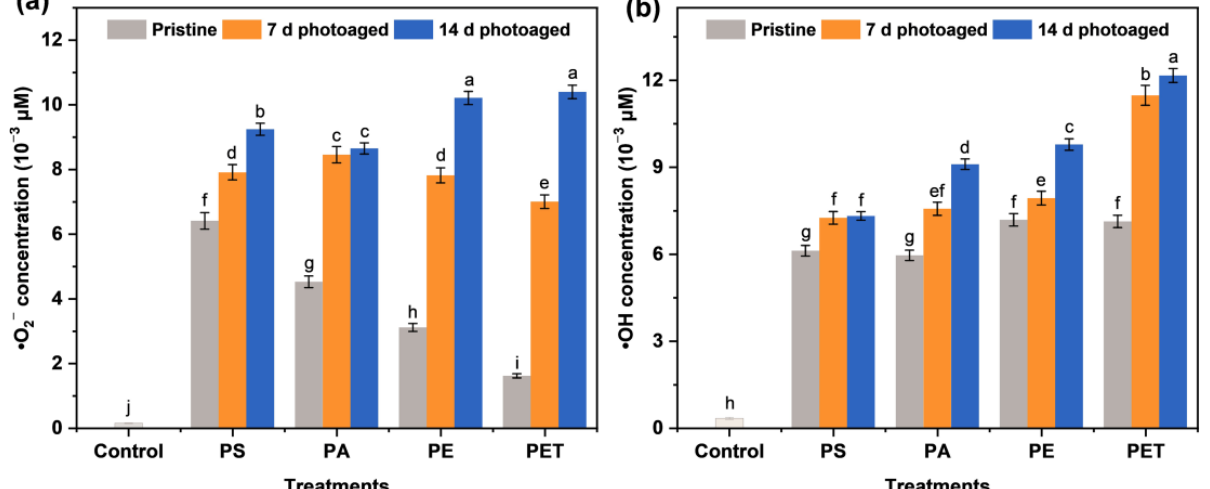
Figure 1. The production of ( a ) superoxide anion radicals (•O 2 − ) and ( b ) hydroxyl radicals (•OH) in suspensions of different microplastics (MPs) of polystyrene (PS), polyamide (PA), polyethylene (PE), and polyethylene terephthalate (PET) after 0, 7, and 14 d of photoaging. The number of samples for the repeated experiments is n = 3. Data are expressed as the mean ± standard deviation (SD). Different lowercase letters indicate significant differences between experimental groups ( p < 0.05).